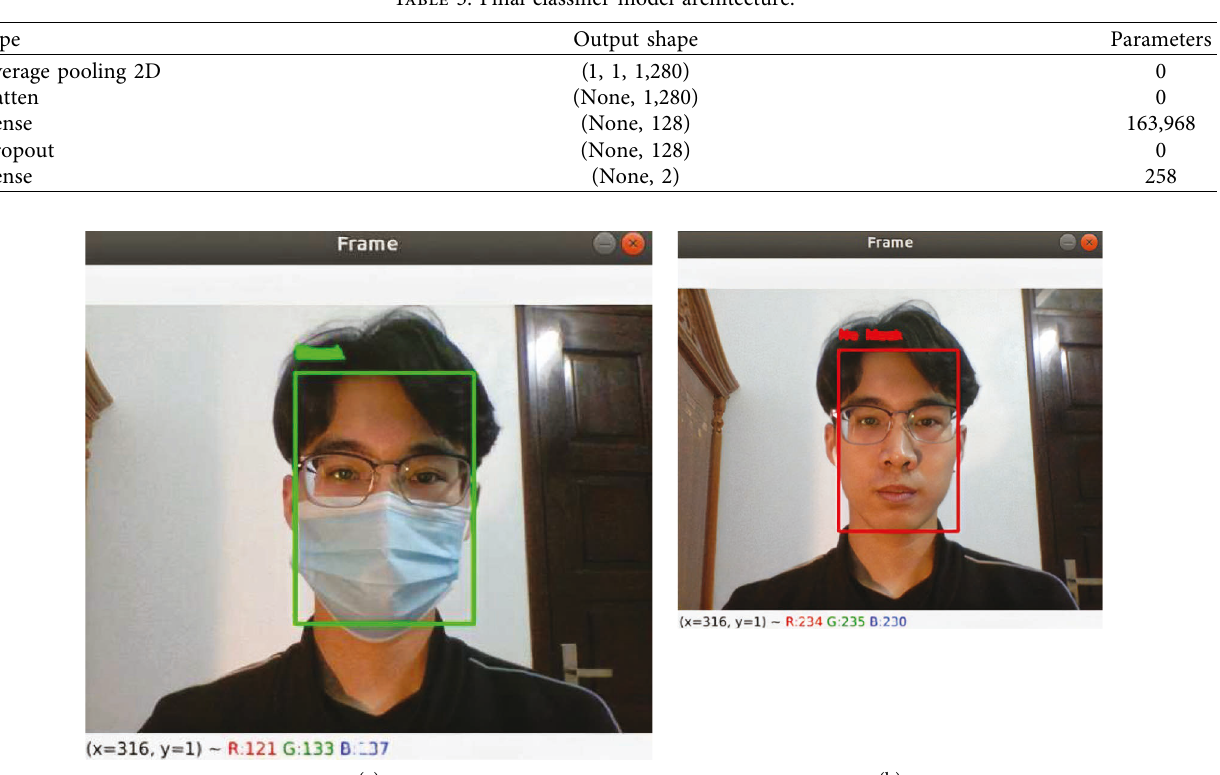
Table 5: Final classifier model architecture.